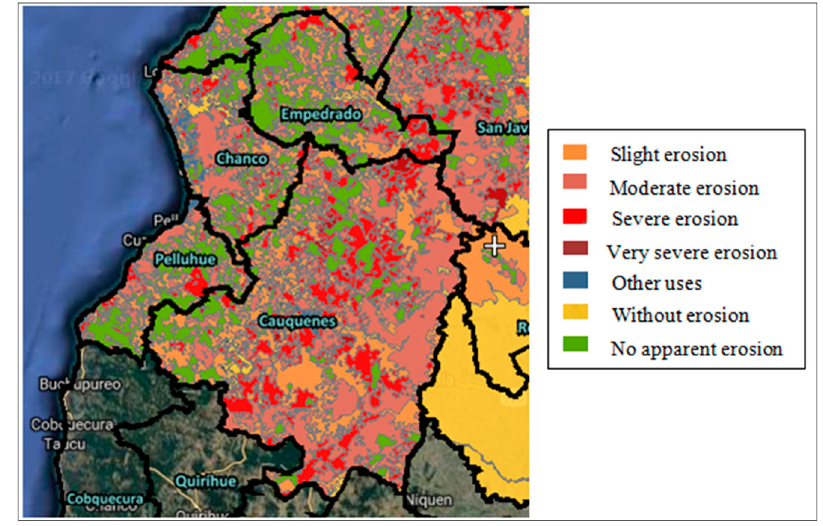
Figure 1. Study area location (within the black circle) and Maule Region land use [29].